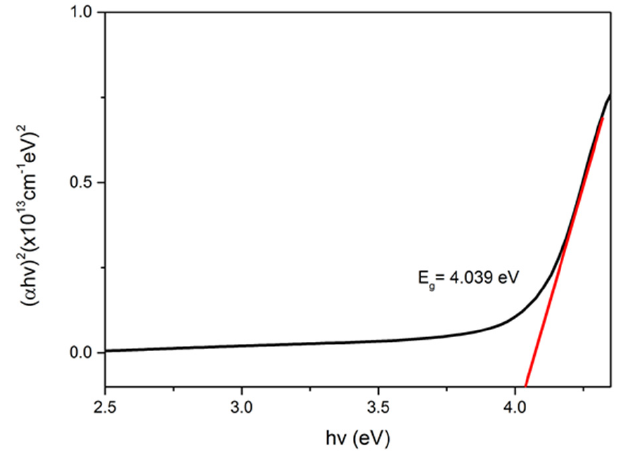
Figure 6. Optical band gap of PVA thin film.